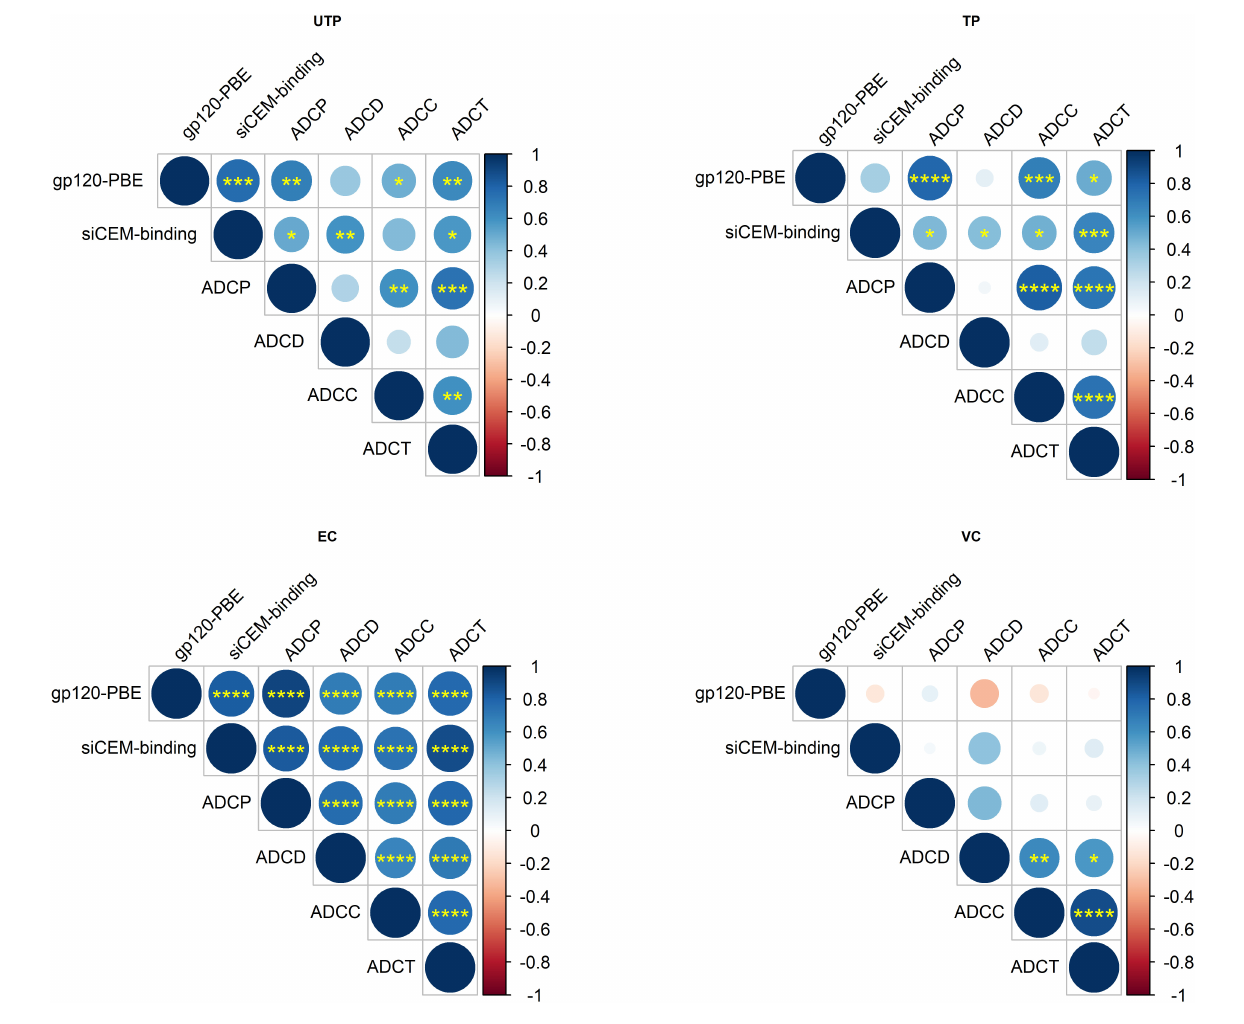
FIGURE 3 | Correlation of AD functions with each other and with anti-HIV-gp120/Env Ab concentrations within HIV-infected subject groups. Correlation matrices for each pairwise combination of AD function and anti-gp120/Env-specific Abs concentrations tested in the four subject groups. Data from 18 UTPs, 24 TPs, 36 ECs and 16 VC were used to generate panel (A) . Data from 17 UTPs, 19 TPs, 36 ECs and 16 VC were used to generate panels (B,C) . The increasing strength of positive correlations are illustrated using increasing blue color depth, as depicted in the legend and by the size of each circle. The statistical significance of pairwise correlations is indicated by the number of “ ∗ ” symbols in each circle (* p < 0.05, ** p < 0.01, *** p < 0.001, **** p < 0.0001). Empty circles represent p-values for correlative relationships that fell below the level of significance ( p > 0.05). Shown are unadjusted p -values to aid in relative comparisons. Correlation coefficients were calculated using Spearman’s correlation tests and they were plotted using Rstudio